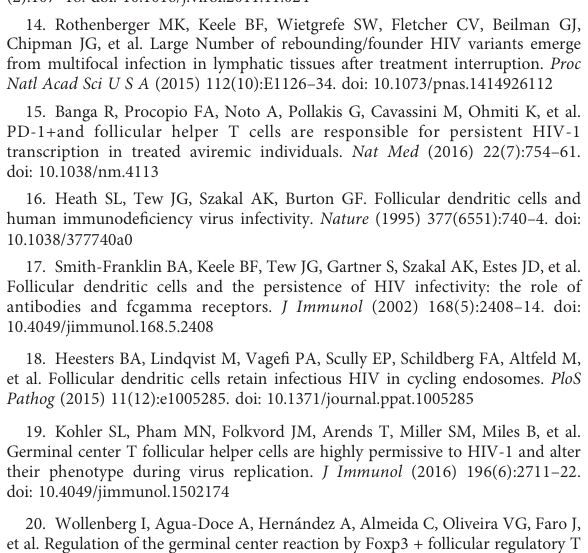
SUPPLEMENTARY FIGURE 7 IL-2 concentration dependent effects of TFR-mediated decrease in HIV replication and TFH viability are similar in TFH infected with CXCR4- or CCR5-tropic HIV. TFH were spinoculated with CXCR4- or CCR5-tropic HIV, labeled with VPD, and cultured at a ratio of 1:1 with uninfected, unlabeled TFH (Control) or TFR for 5 days in the absence or presence of